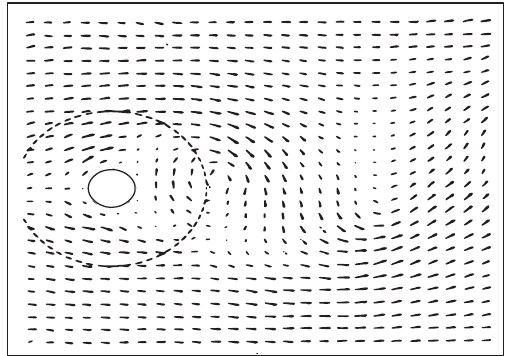
Figure 19: Experimental surface velocity vector fields of wake of